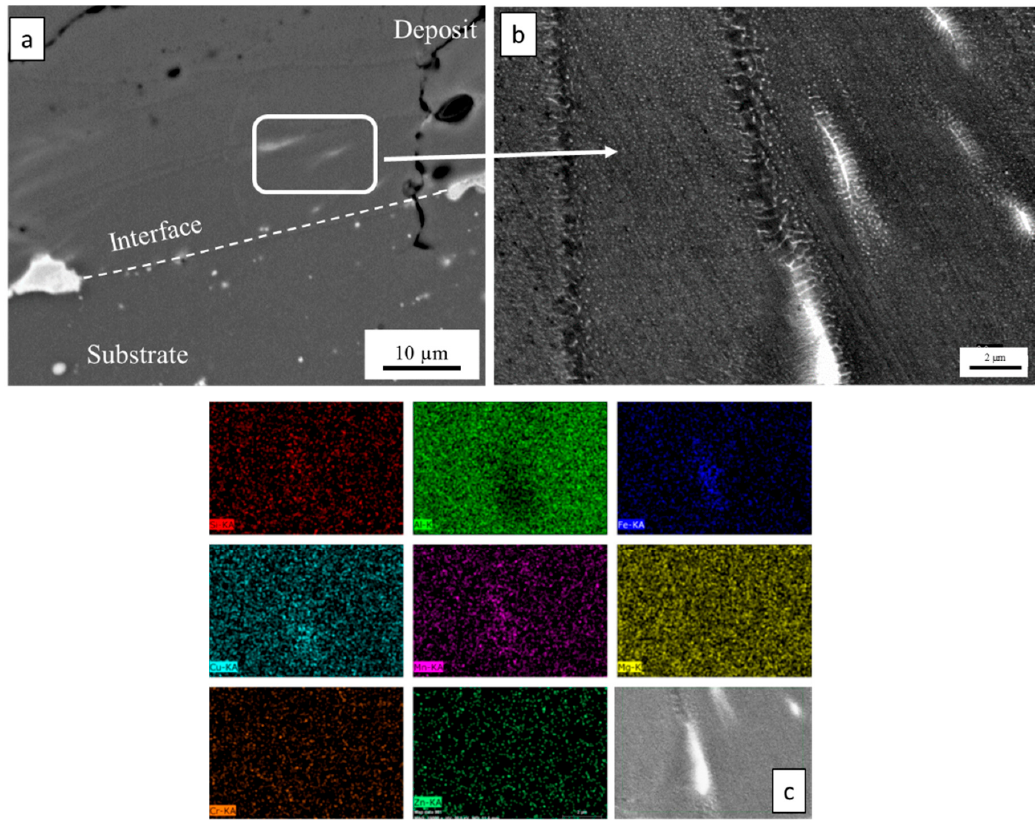
Figure 9. ( a ) SEM micrograph showing the interface layer between deposit and substrate alloy ( b ) SEM micrograph (backscattering mode) showing the microstructure of deposit/substrate interface and ( c ) energy dispersive spectrometry (EDS) map to interface layer.